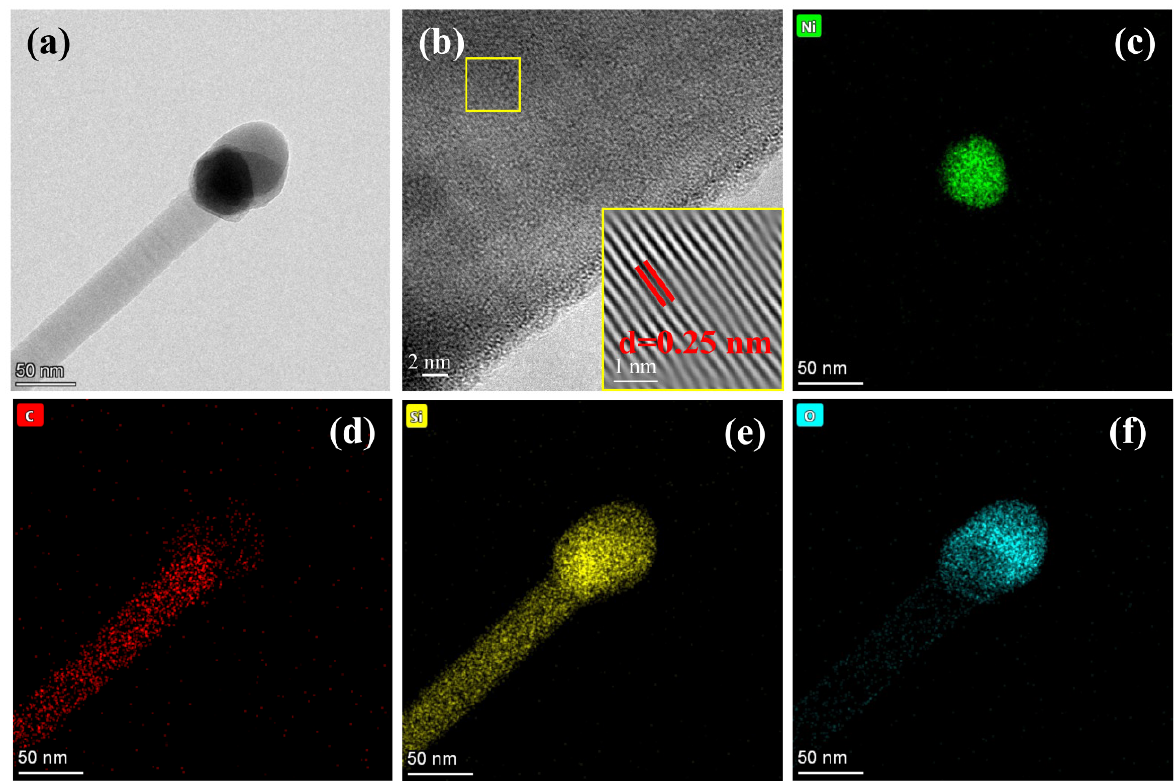
Figure 3. Microstructure of SiCNWs grown via AD method with reaction times of ( a , b ) 1 h, ( c ) 3 h, and ( d ) 5 h.